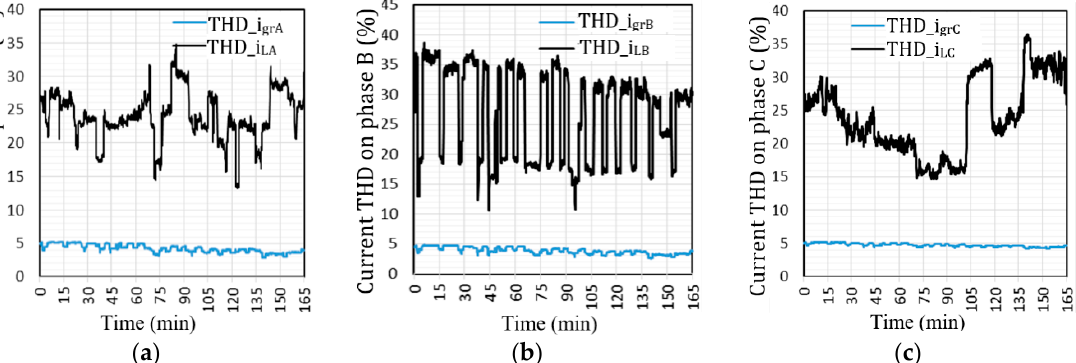
Figure 18. Waveform, harmonic spectrum and THD of the current on phase B: downstream of the PCC ( a – c ); upstream of the PCC ( d – f ).